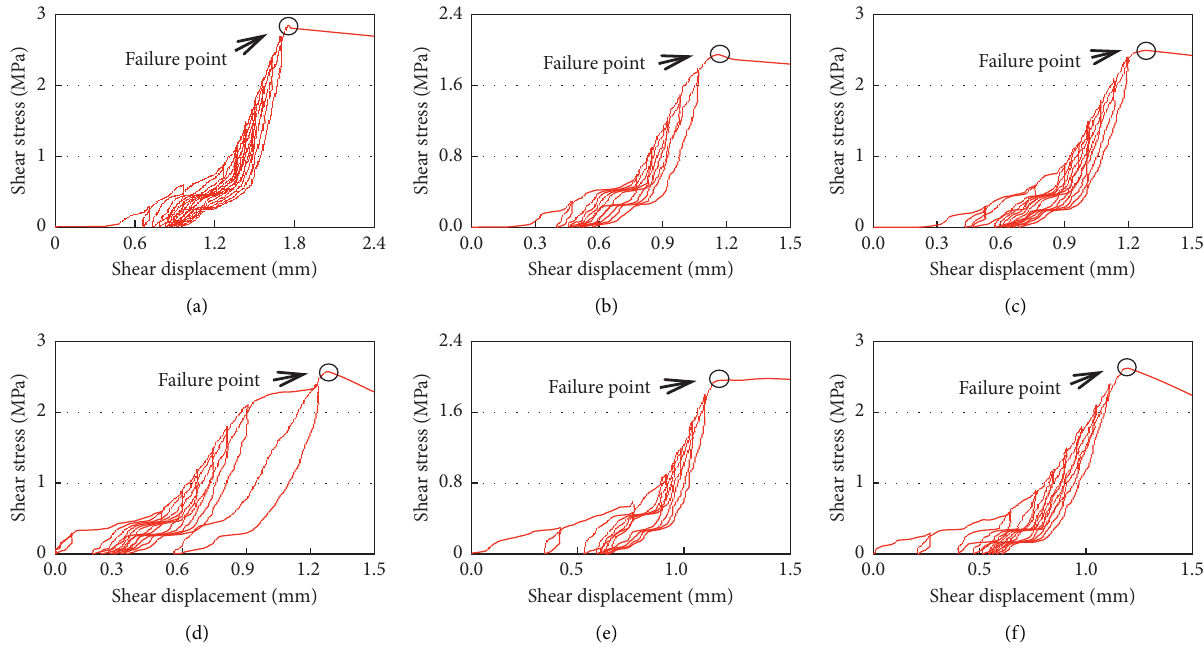
Figure 7: T - δ curves under tiered cyclic shear loading for (a)–(f): TJ-1–TJ-6.